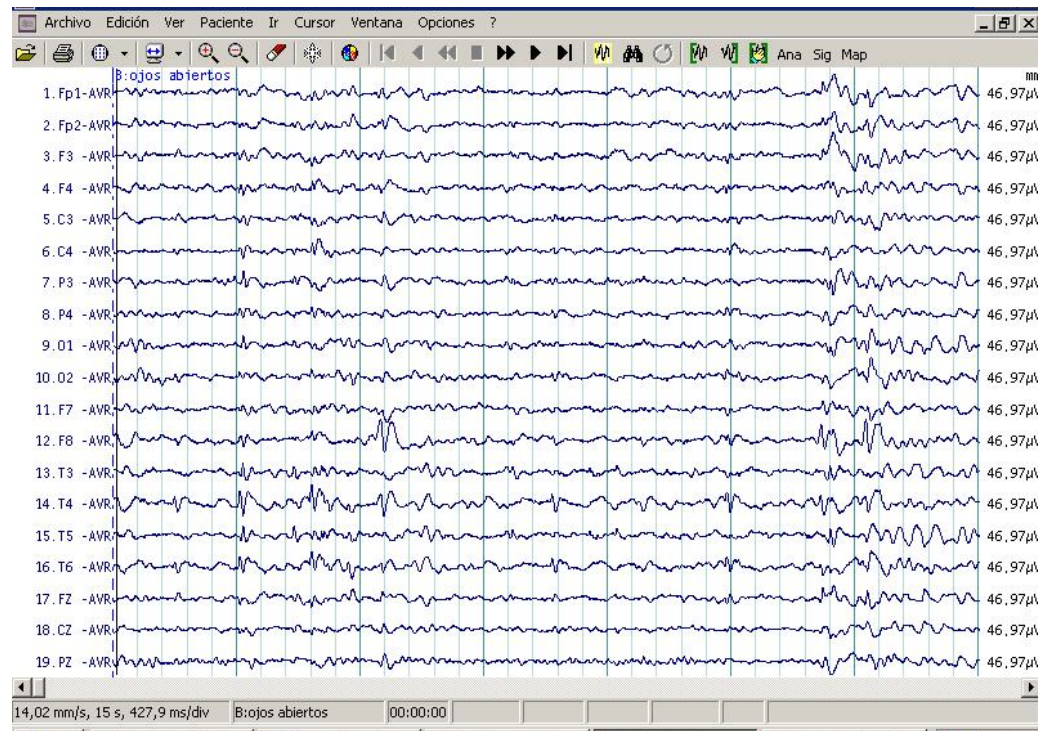
Figure 1. Routine awake electroencephalography (EEG) study in patient with ASD with epileptic seizures. Note EEG independently epileptiform abnormality in channels containing the frontal and temporal leads in both hemispheres. Maximum amplitude occurred in F8, T4, Fp1, and F3.